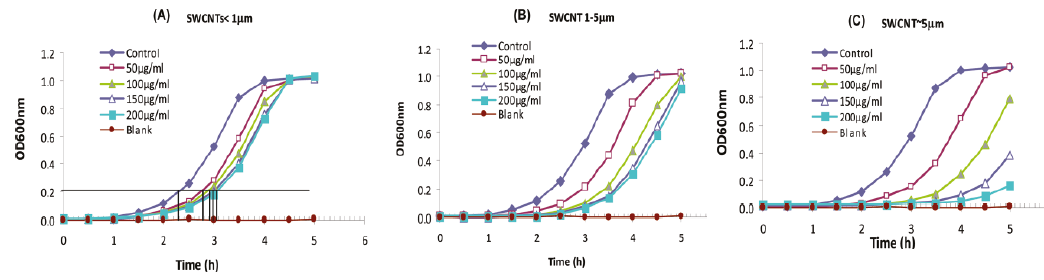
Figure 6. ( A – C ) Optical density (OD) growth curves measurement of Salmonella cells when 180 μL of ∼ 8.0 × 10 7 cfu/mL cells was treated at the following conditions and grew in 5 mL BHI at 37 °C: ( A ) single-walled CNT (SWCNT) of <1 μm long, ( B ) 1–5 μm long, and ( C ) 5 μm long, at various concentrations of blank, 50, 100, 150, and 200 μg/mL [62] (modified and cited with permission from ACS Chemical Society).